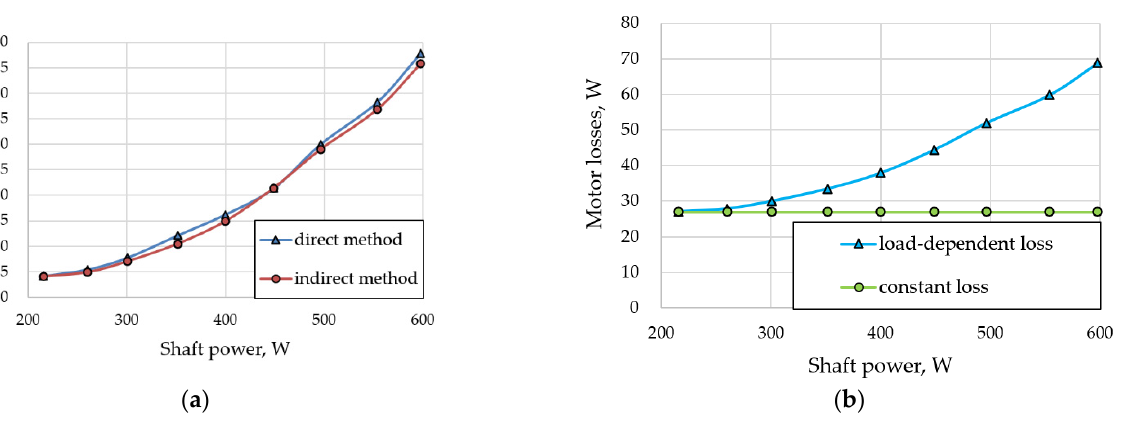
Figure 6. Experimental results: ( a ) comparison of total loss by the input-output method and the proposed indirect method; ( b ) separate losses evaluated using the indirect method.